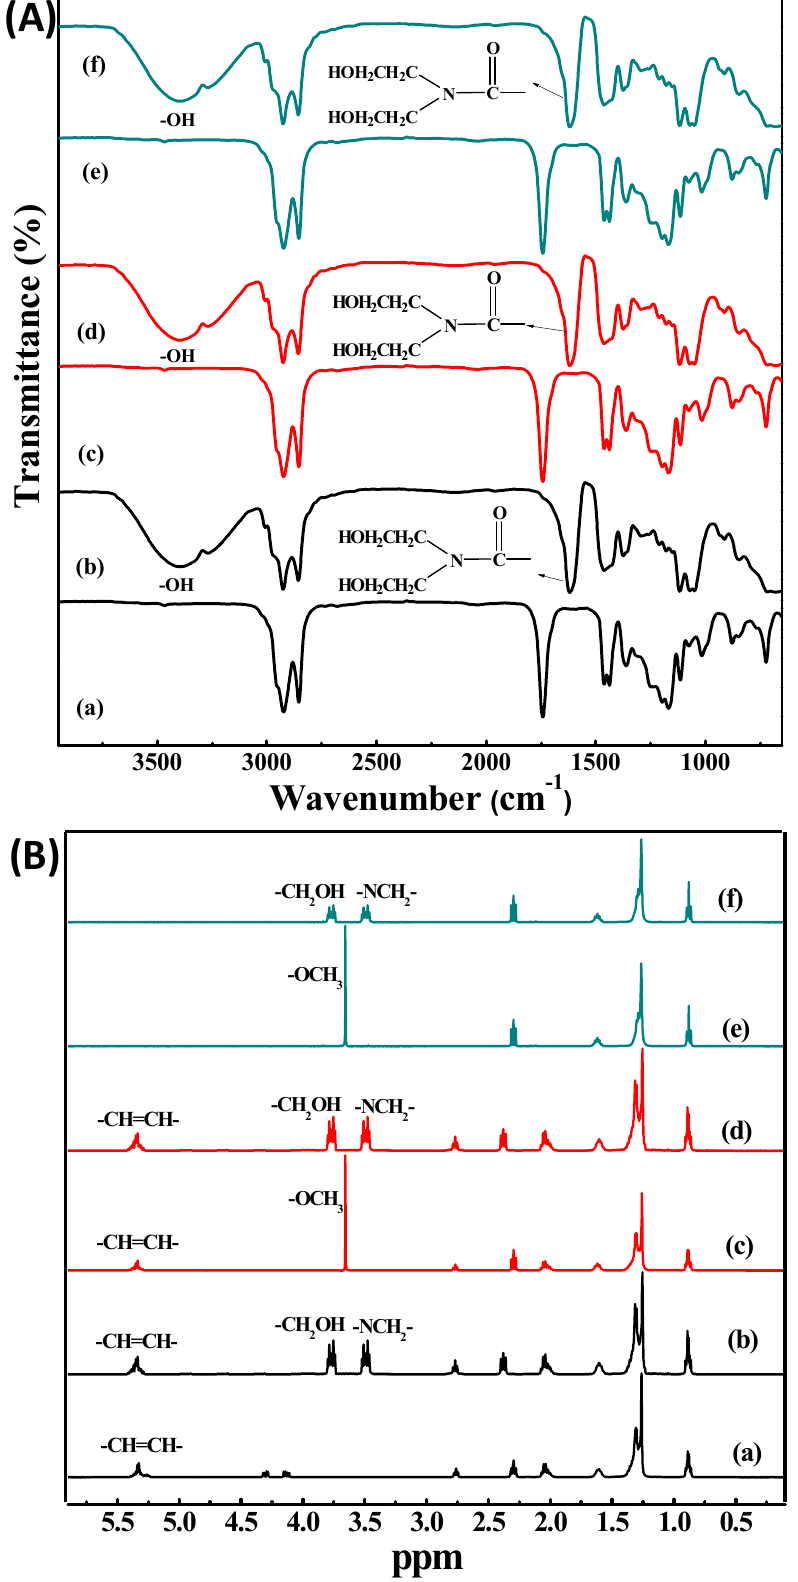
Figure 3. Comparative ( A ) FTIR spectrum and ( B ) 1 H-NMR spectrum of ( a ) waste cotton seed oil, ( b ) fatty acid amide of waste cotton seed oil, ( c ) waste soybean oil (WSO)-derived FAMEs, ( d ) a fatty acid amide of WSO-derived FAMEs, ( e ) methyl laurate, and ( f ) an amide derivative of methyl